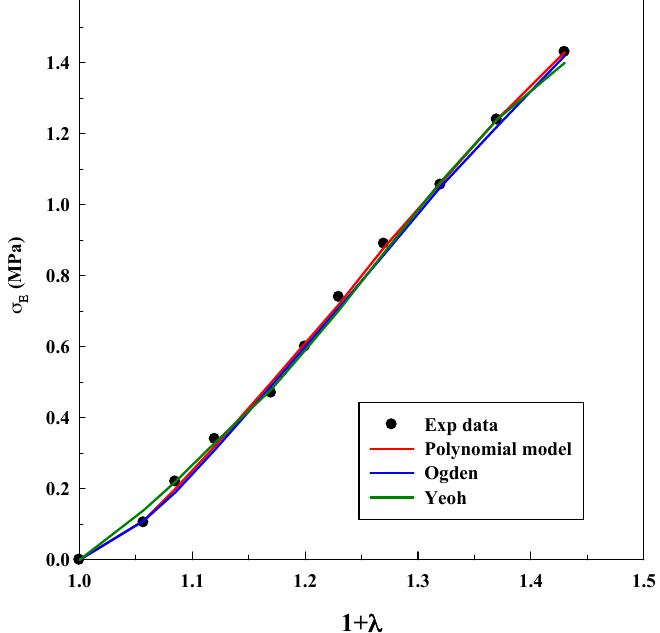
Figure 5. Models fitting of stress–elongation for the system A/G 50/50% v / v at 5% w / w .